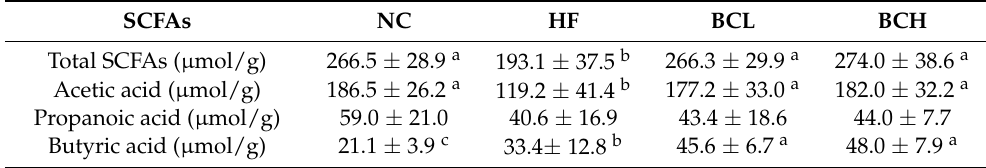
Table 3. Changes in the concentrations of fecal short chain fatty acids among different